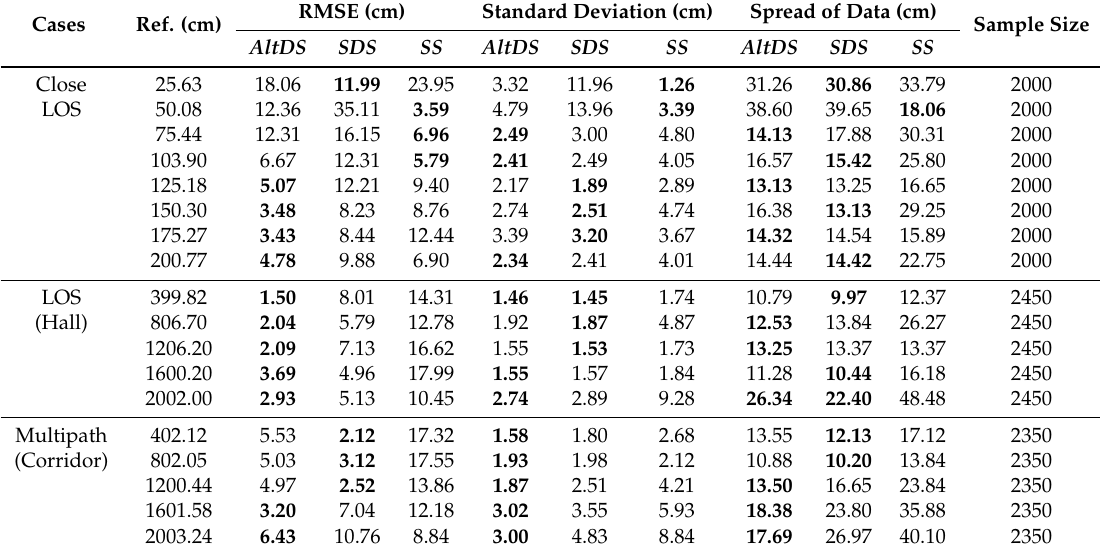
Table 6. Experiment evaluation results for typical case (Type III) at different